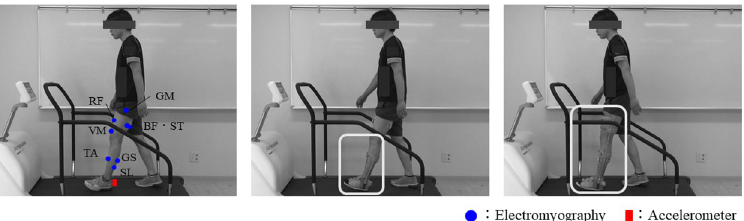
Fig 1. Measurement of the three conditions. Blue circles and red squares show the positions of the electromyography and accelerometer, respectively. An accelerometer was attached to the posterior surface of the shoe to detect heel contact during